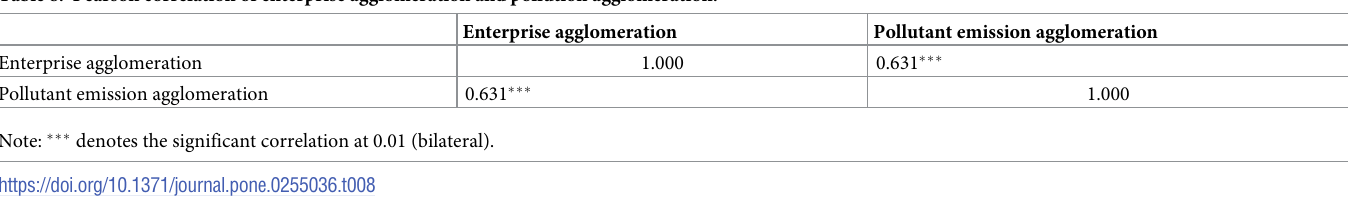
Table 8. Pearson correlation of enterprise agglomeration and pollution